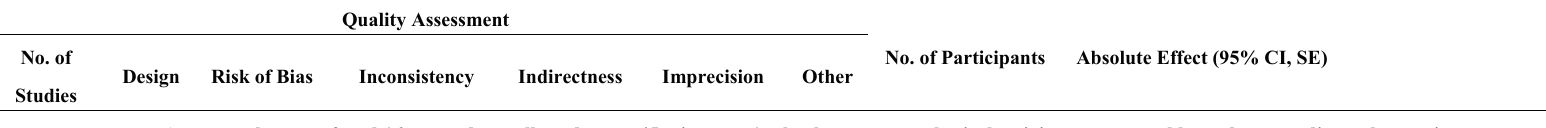
Table 2. Associations between outdoor time and acute physical activity.